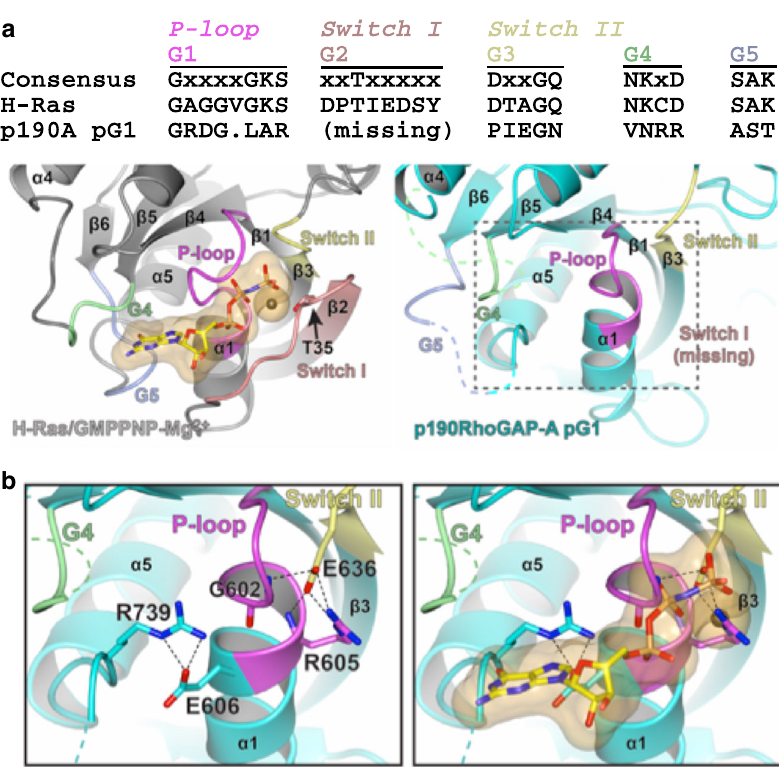
Fig. 3 Analysis of the degraded nucleotide binding pocket of p190RhoGAP pG1. a Alignment ( top ) and structural comparison ( bottom ) of conserved G motifs for H-Ras (PDB ID: 5P21 56 ) and p190RhoGAP-A pG1 (p190A). Conserved threonine T35 for H-Ras is shown. Dashed box indicates region shown in b . b Close-up of the disrupted nucleotide-binding site of p190RhoGAP-A pG1 domain ( left ) and additional space fi lling model indicating the location of GTP analog when H-Ras is superposed onto the structure ( right